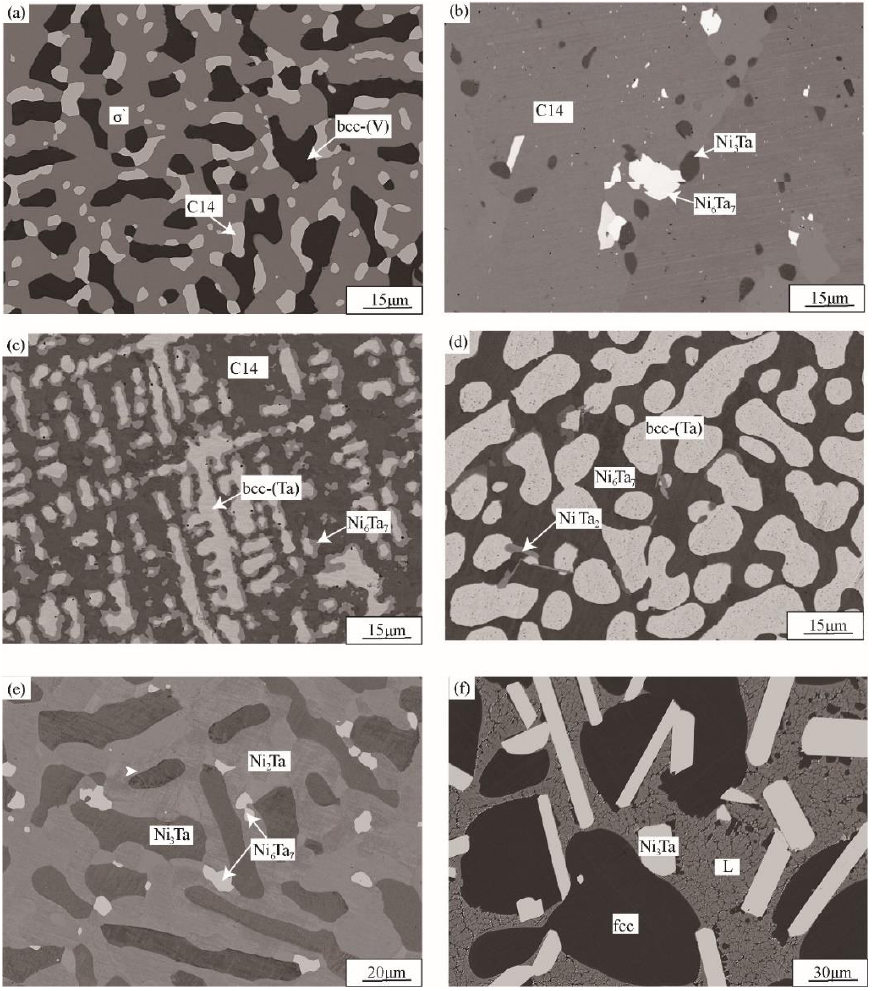
Figure 5. Microstructure of the typical alloys in the Ni-V-Ta system annealed at 1200 °C for 40 days. ( a ) Ni 24 V 67 Ta 9 ; ( b ) Ni 48 V 18 Ta 34 ; ( c ) Ni 14 V 36 Ta 50 ; ( d ) Ni 19 V 11 Ta 70 ; ( e ) Ni 64 V 5 Ta 31 ; and ( f ) the Ni 61 V 30 Ta 9 alloy annealed at 1200 °C for 3 h.